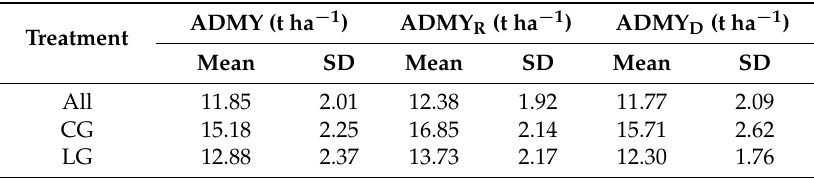
Table 5. Measured total annual dry matter yield including four cuts (ADMY) and the predicted ADMY based on manual height measurement (ADMY R ) and UAV-based RGB imaging (ADMY D ) for the whole dataset (All) and the two different mixtures clover-grass (CG) and lucerne-grass (LG). For better understanding DMY data was re-transformed to the original scale. SD = standard